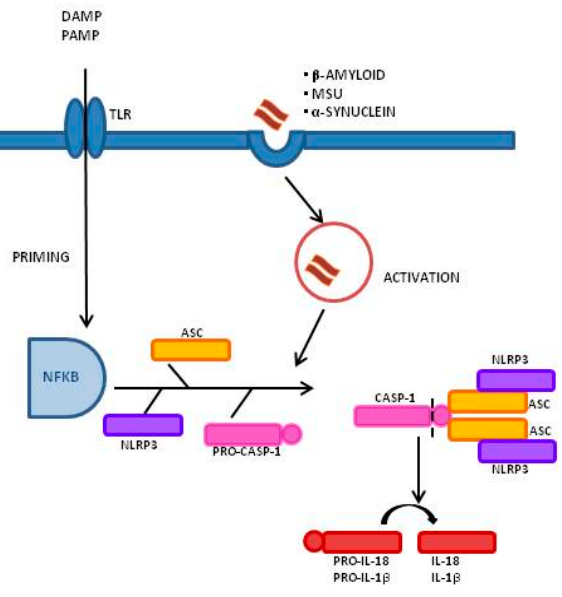
Figure 1. Inflammasome activation process and signaling mechanism: A Two ‐ Signal Model for NLRP3 Inflammasome Activation. The priming signal (signal 1, left) is provided by damage ‐ associated molecular patterns (DAMP) or by pathogen ‐ associated molecular patterns (PAMP), leading to the activation of the transcription factor NF ‐κ B and subsequent upregulation of NLRP3, pro ‐ interleukin ‐ 1 β (pro ‐ IL ‐ 1 β ), and pro ‐ interleukin ‐ IL ‐ 18 (pro ‐ IL ‐ 18). The activation signal (signal 2, right) is provided by a variety of stimuli including β‐ amyloid, α‐ synuclein, and Monosodium Urate Crystals (MSU), leading to the assembly and formation of the NLRP3 inflammasome through the combination of NLRP3, ASC, and procaspase ‐ 1, and leading to the production of caspase ‐ 1, which catalyzes the transformation from pro ‐ IL ‐ 1 β and pro ‐ IL ‐ 18 into IL ‐ 1 β and IL ‐ 18.